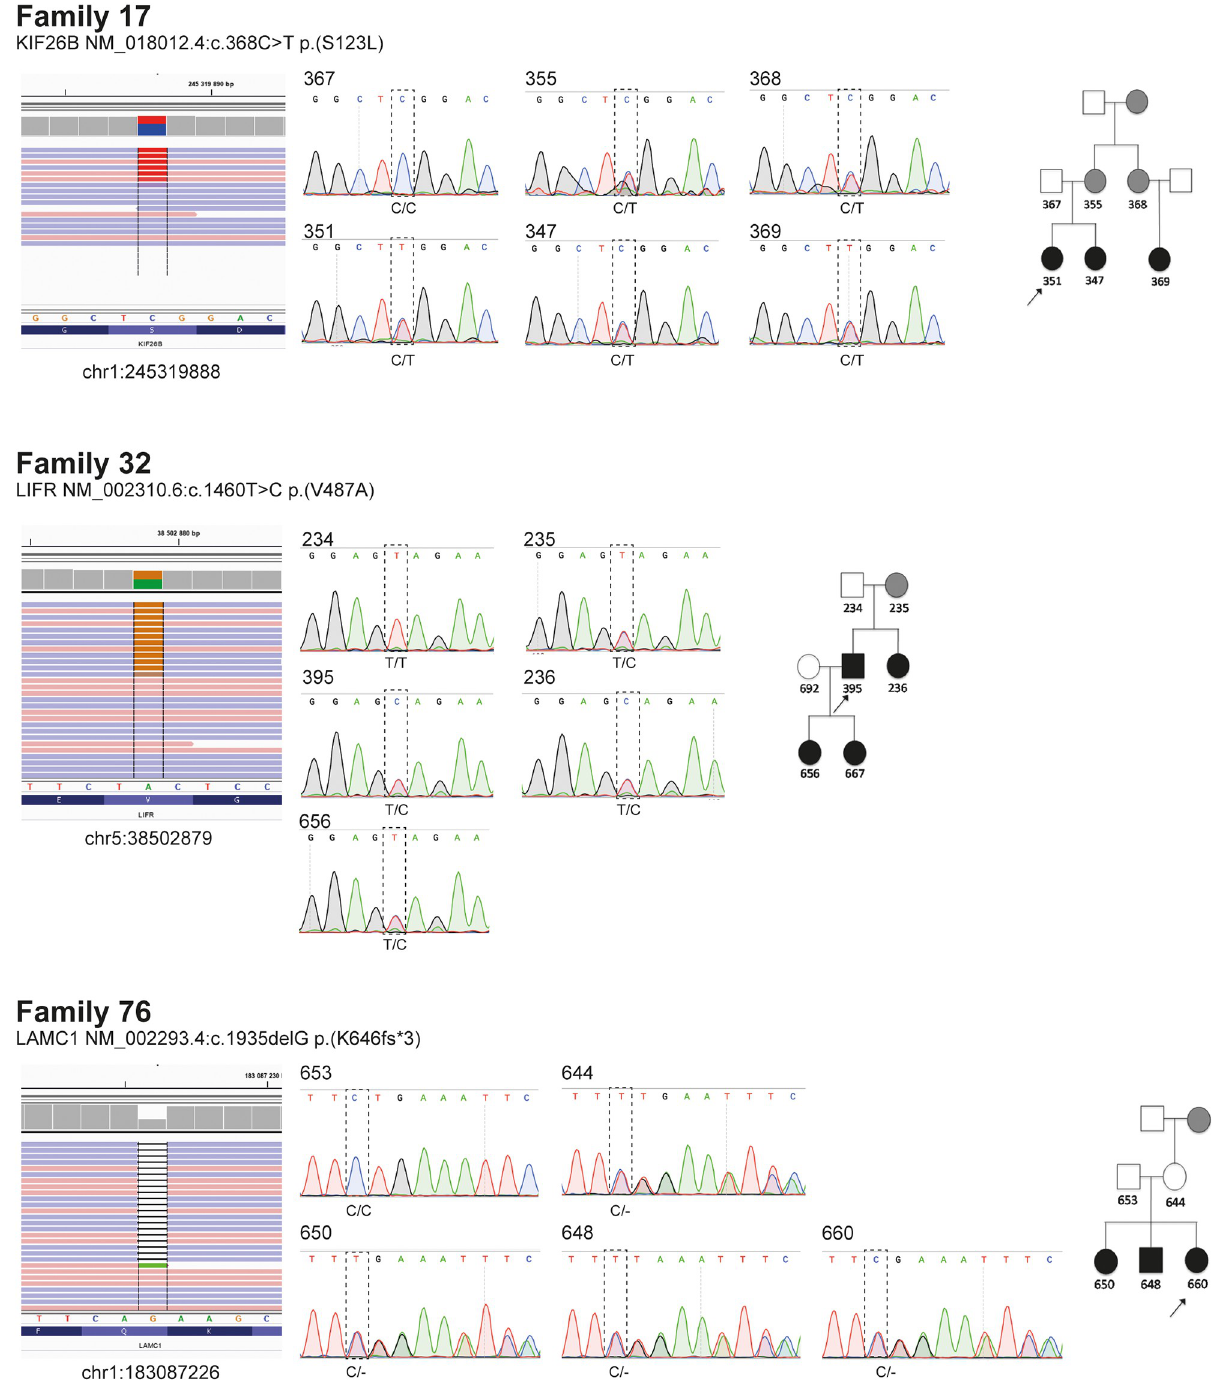
Fig 4. Variant identification and segregation analysis. Candidate variants detected by WES visualized in IGV with genomic position as indicated (left panels). Electropherograms from Sanger sequencing over corresponding positions show that the variants in KIF26B (fam. 17), LIFR (fam. 32) and LAMC1 (fam. 76) segregate with disease in respective